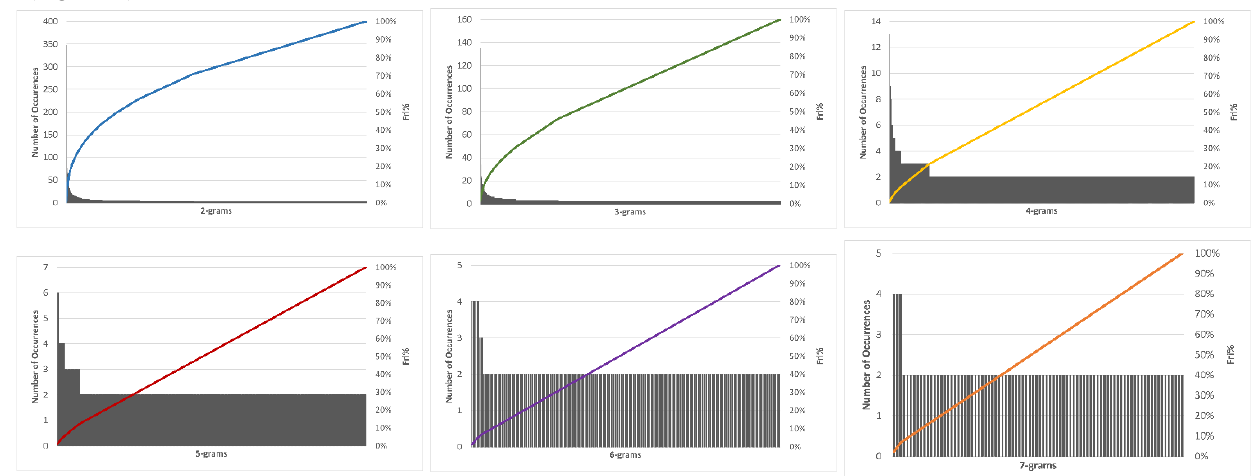
Figure 5. Histograms of the different n -grams from HCII: (a) bigram; (b) trigram; (c) quadgram; (d) pentgram; (e) hexagram; (f) heptagram.